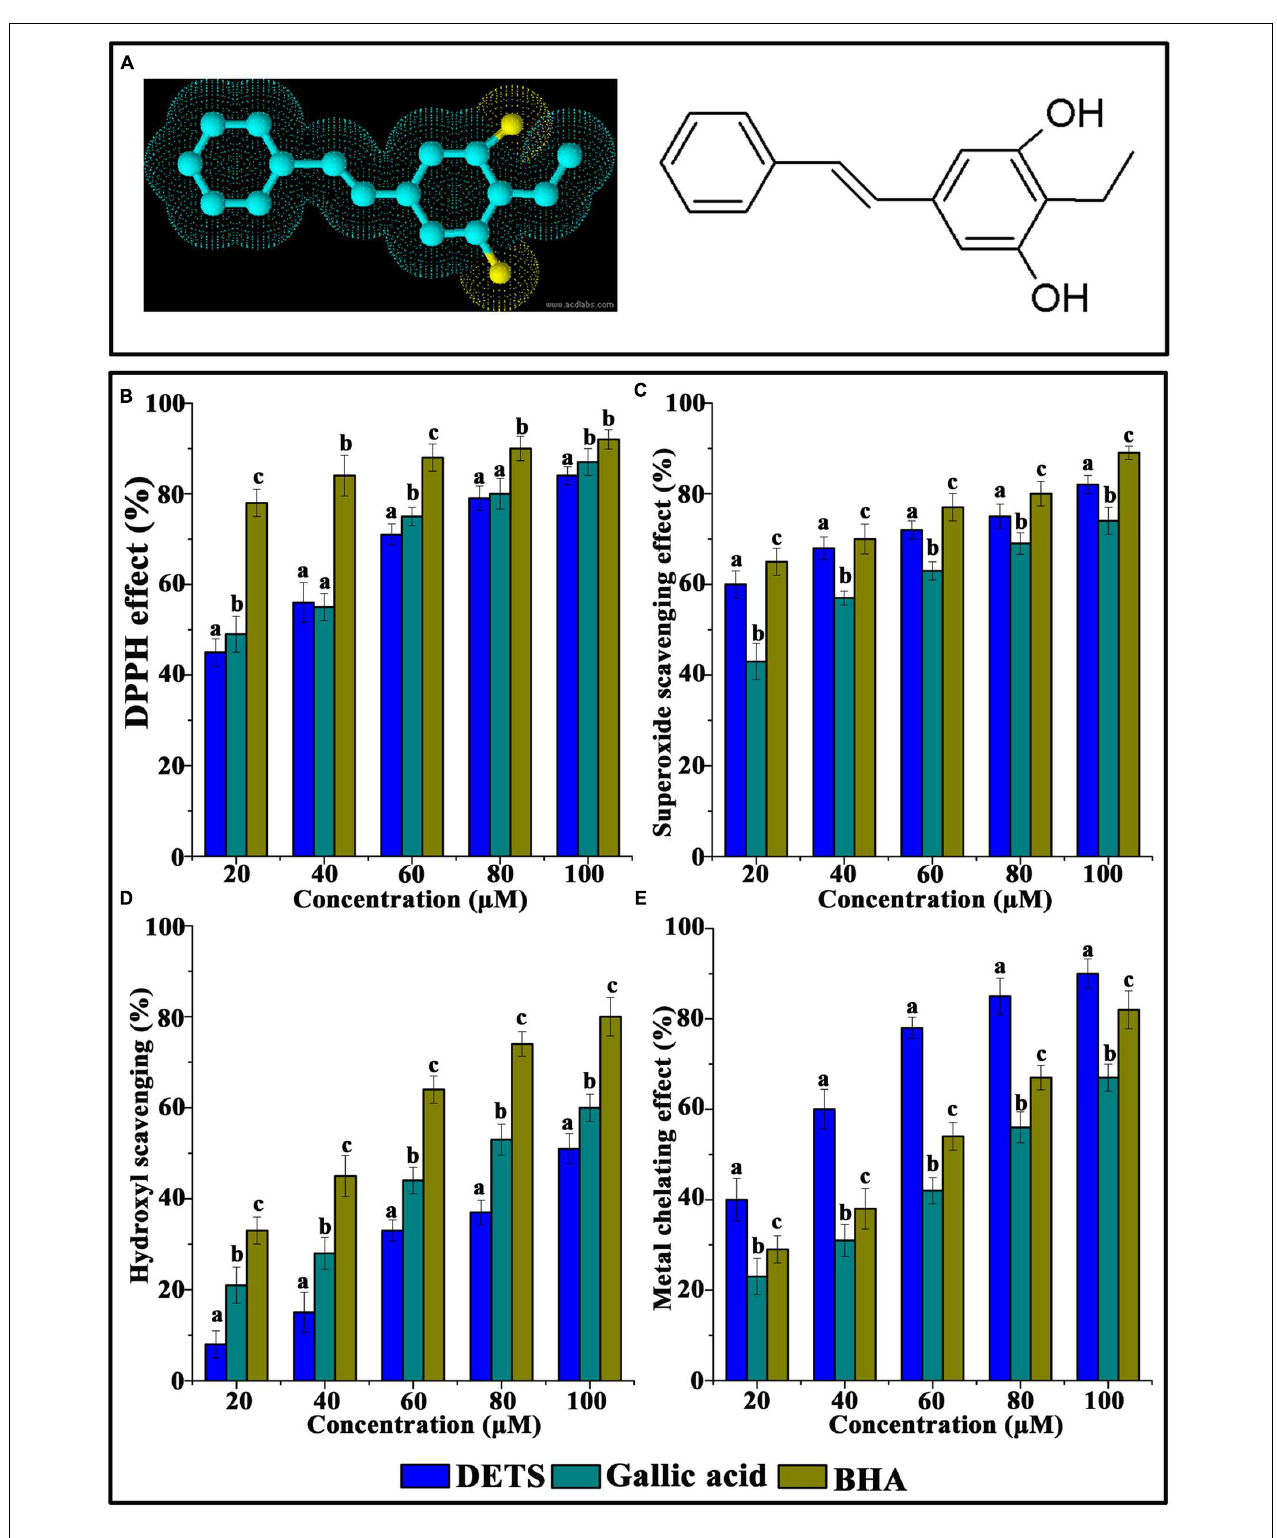
FIGURE 1 | Chemical structure and antioxidant activity of DETS in various in vitro assays. (A) Structure of DETS (B) Free radical scavenging, (C) superoxide radical-(02 − ) scavenging assay, (D) hydroxyl radical scavenging activity (E) metal chelating activity. All the measurements were done in three replicates and results are expressed as arithmetic mean ± standard error on the mean. Different letters in the superscript were significantly different according to Duncan’s multiple range test ( p < 0.05).